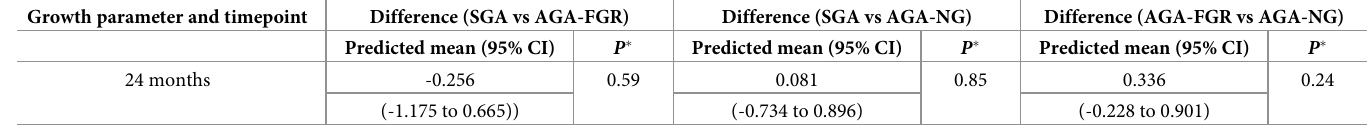
normal antenatal growth; CI confidence interval; BMI body mass index.